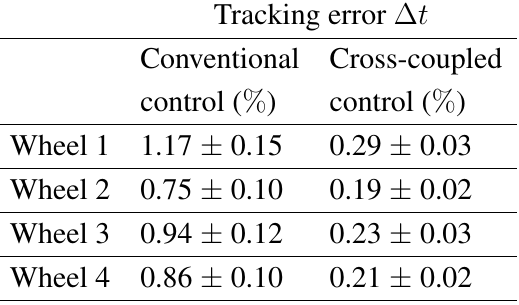
Table 1. Tracking error for the rover Dune during 5-meter straight-line experiments on agricultural terrain (V = 10 cm/s).